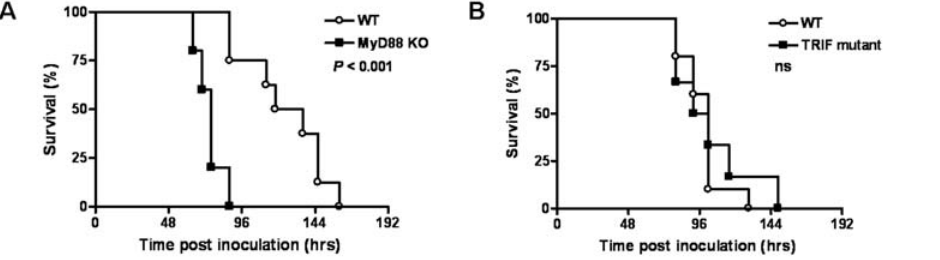
Figure 2. MyD88 KO, but not TRIF KO, mice show an accelerated mortality during experimental melioidosis. Survival of wild-type (WT, open rounds) and MyD88 KO mice (black squares) (A) or TRIF mutant (black squares) mice (B) intranasally infected with 5 6 10 2 CFU B. pseudomallei . Mortality was assessed twice daily for one week. n=8–10 per group; ns denotes not significant; P value indicates the difference between MyD88 KO and WT